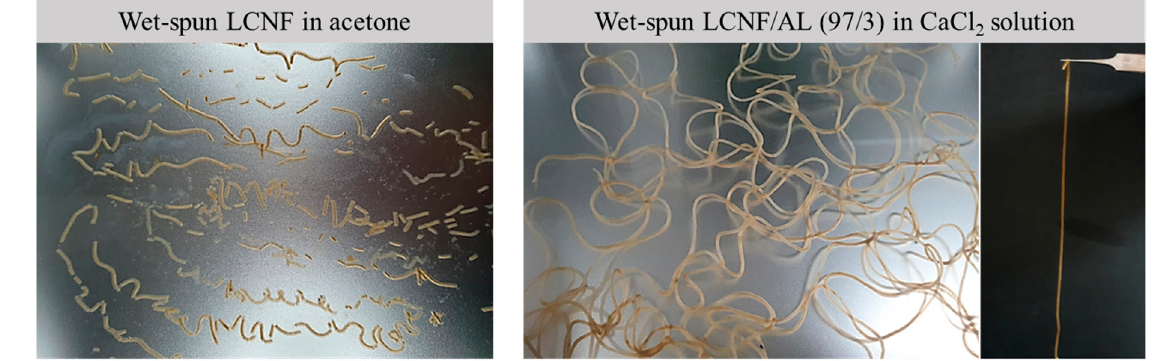
Figure 3. The effect of AL addition in LCNF suspension on wet-spinnability.